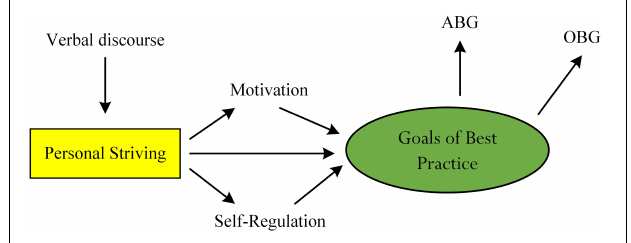
FIGURE 6 | The use of personal striving as educational